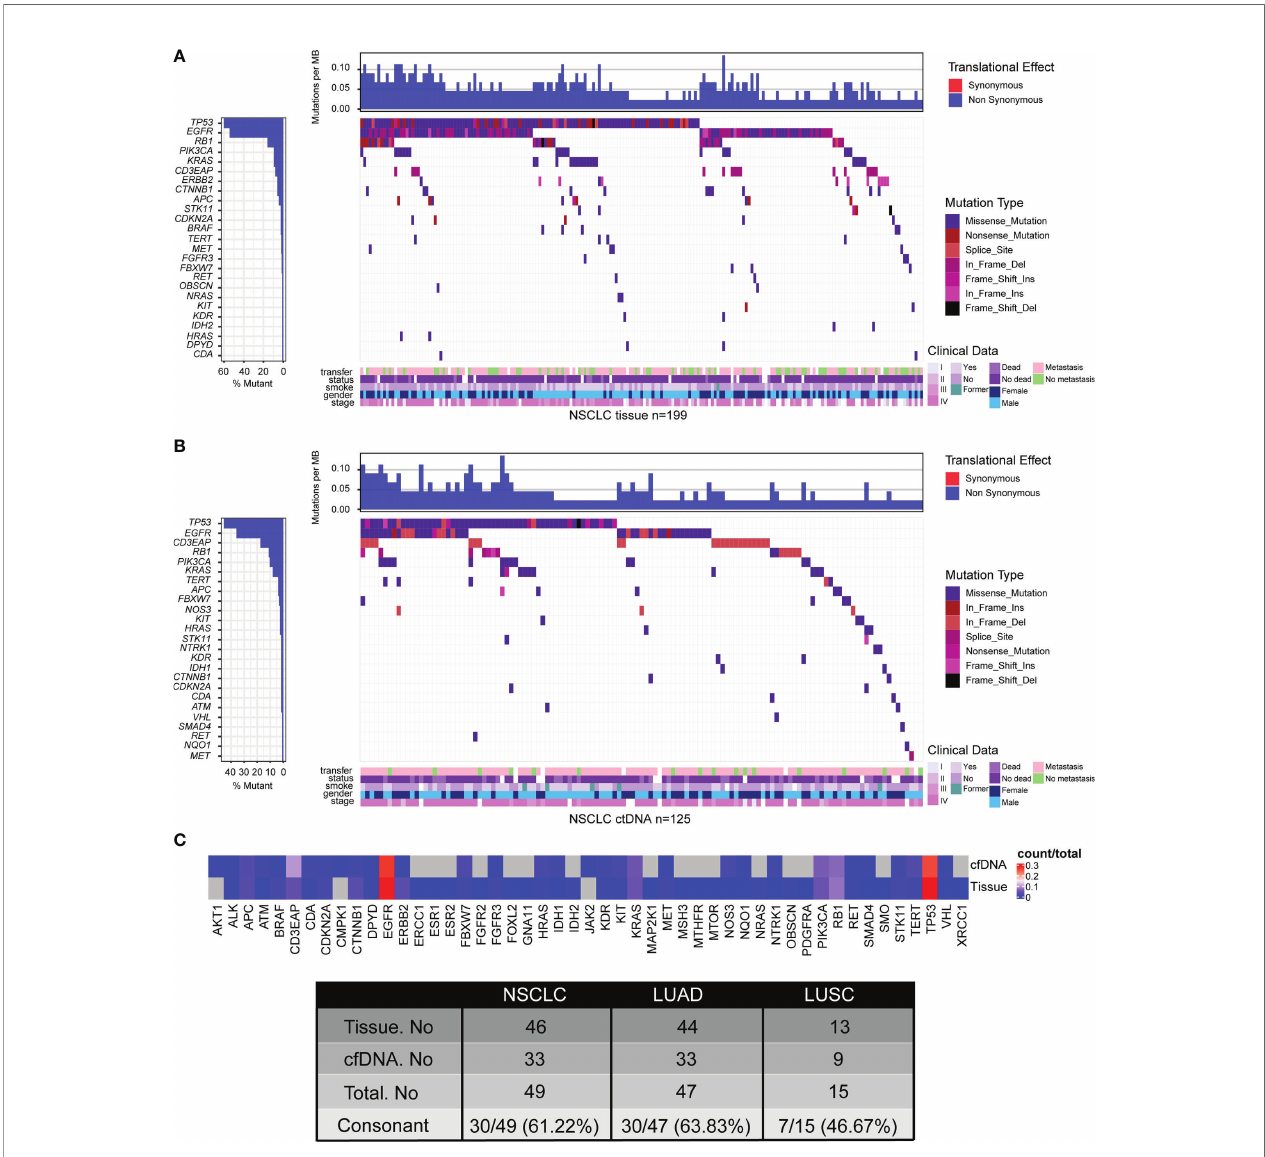
FIGURE 1 | Tumor mutation landscape of NSCLC derived from tumor tissue DNA (n = 213) (A) and ctDNA (n = 139) (B) . Concordance of mutated genes derived from tumor tissue DNA or ctDNA in NSCLC patients (C) . Patients were arranged along the x-axis. Signi fi cantly mutated genes identi fi ed by VarDict were ranked by mutation frequencies and clinical characteristics. Tumor mutation burden (TMB, mutations per Mb) is shown in the upper panel. The bars on the left represent the mutation frequency of each